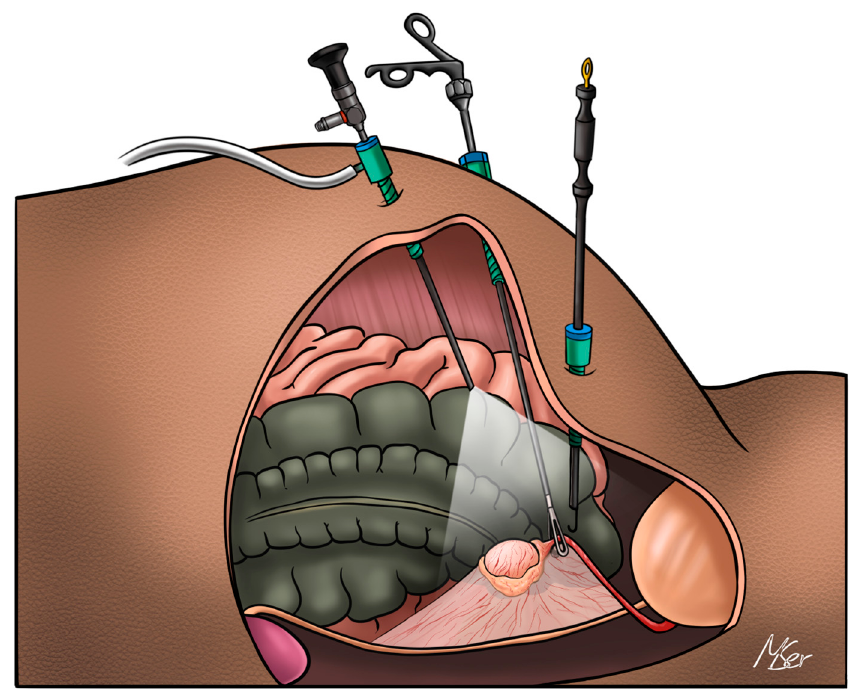
Figure 2. Instrument positioning for vasectomy in Myocastor coypus (right lateral view).